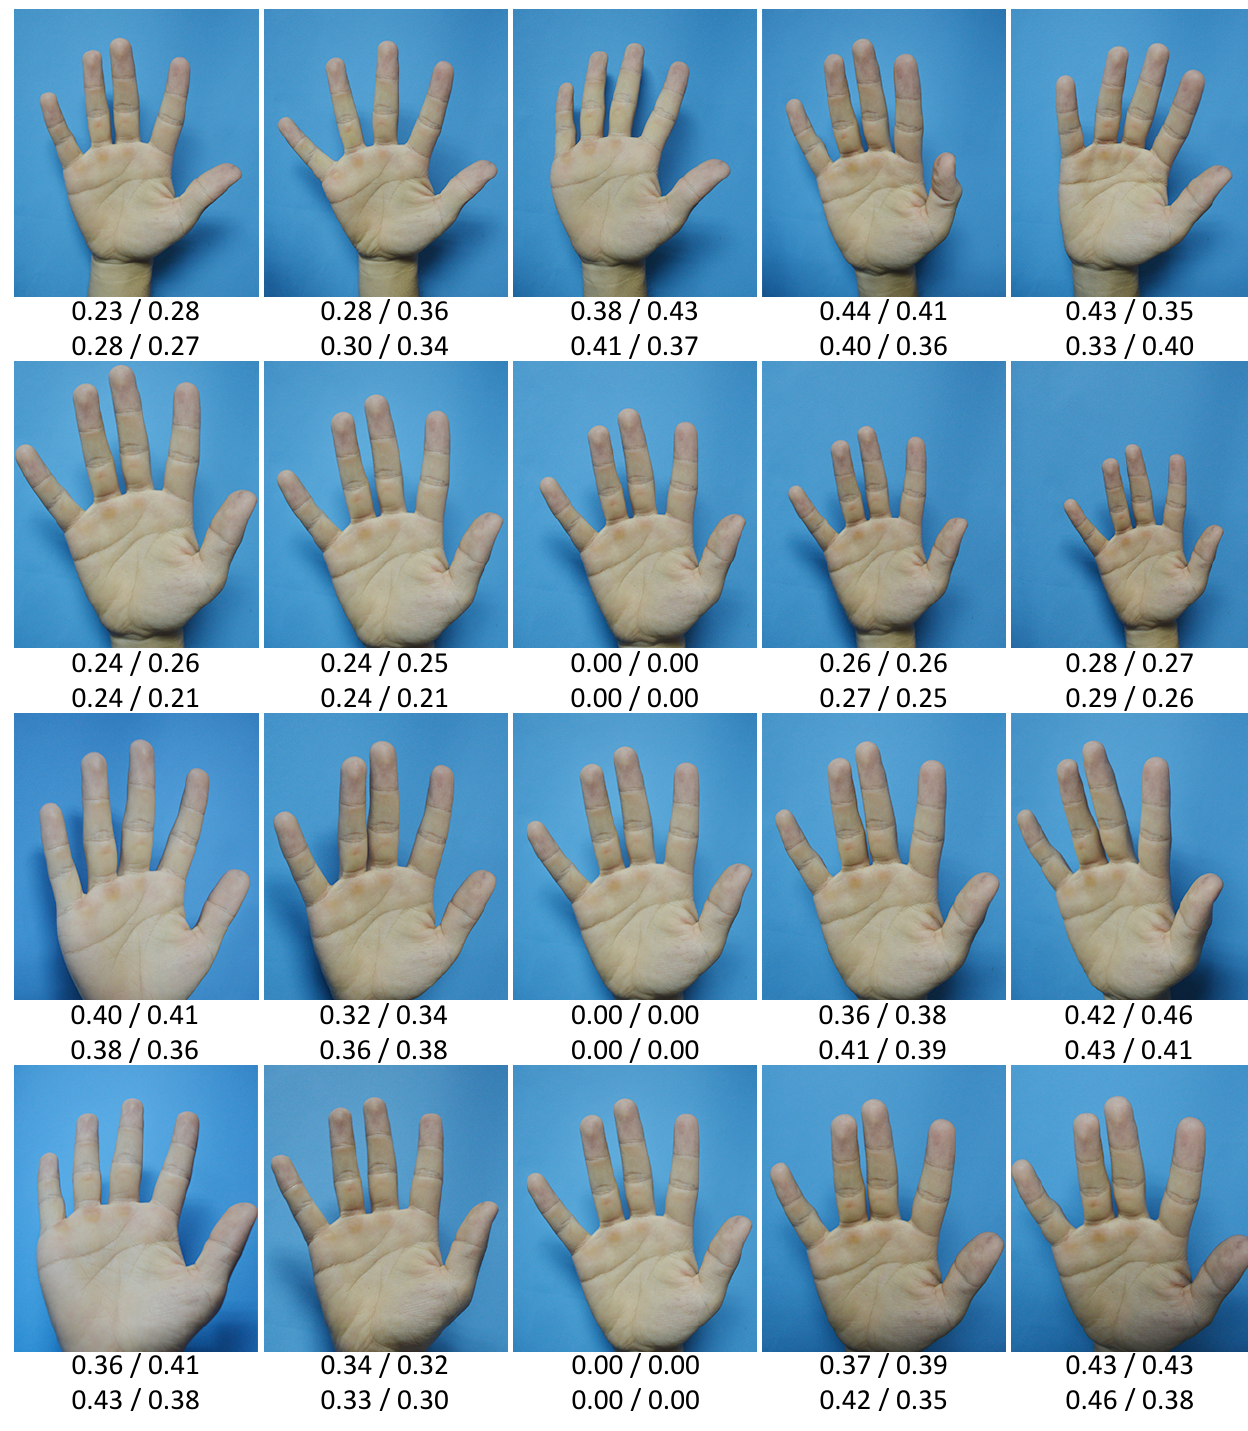
Figure 14. Samples of the deformed IKP images that can be tolerated by our method. From top to bottom: different postures, viewpoints from near to far, viewpoints from left to right, viewpoints from bottom to top. The four values under each image indicate the matching distances of the four IKP ROIs respectively. The threshold applied here T = 0 . 41 is the threshold corresponding to the FFRR from DB-2, and the matching decision is made based on integrated ROI